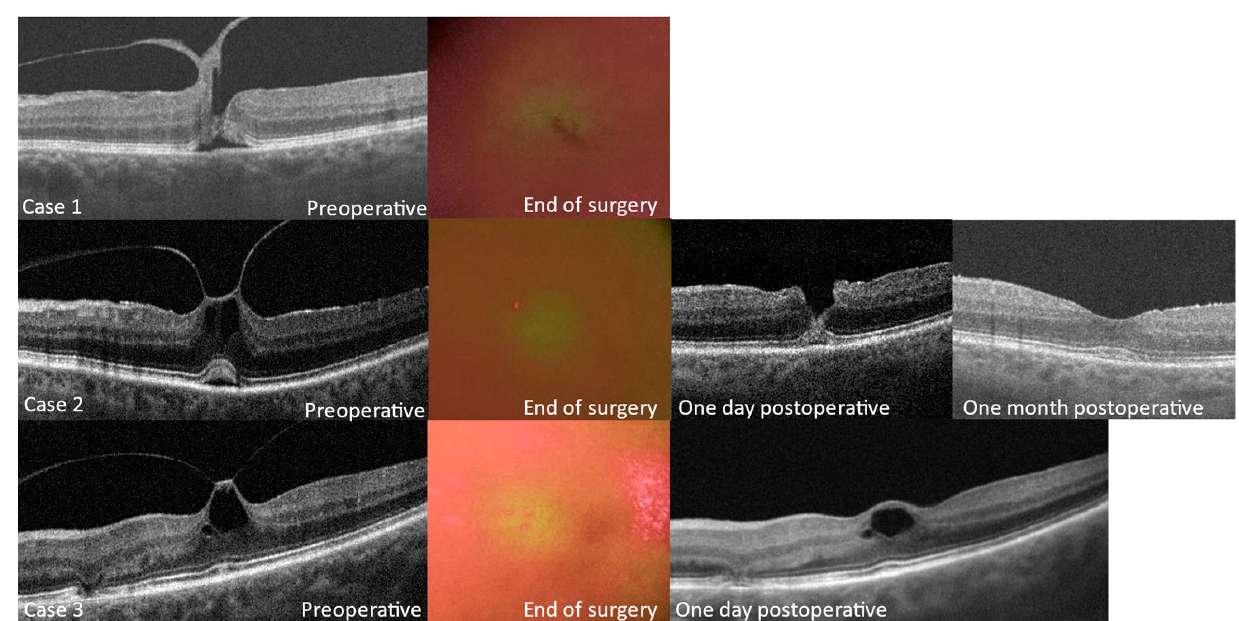
Figure 2. Analysis of macular pigmentation with filter 1 at the end of surgery in cases of vitreomacular traction. Preoperative and postoperative scans of patients are presented except for case 1 who had gas tamponade. In case 1, the MP appears to have a defect. In cases 2 and 3, the MP has a regular appearance. Note small artifacts in case 3 related to triamcinolone deposits.